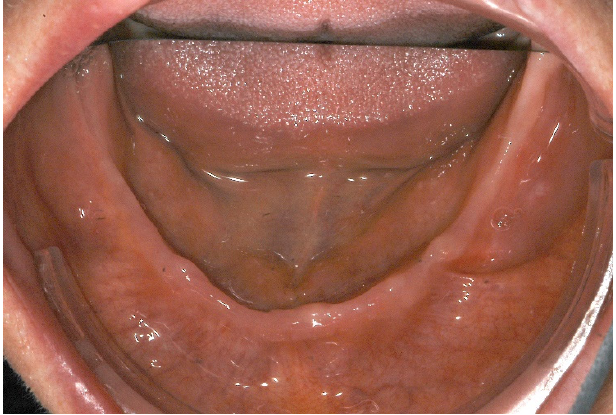
Figure 1. Intraoral situation with pronounced atrophy of the mandibular alveolar process.